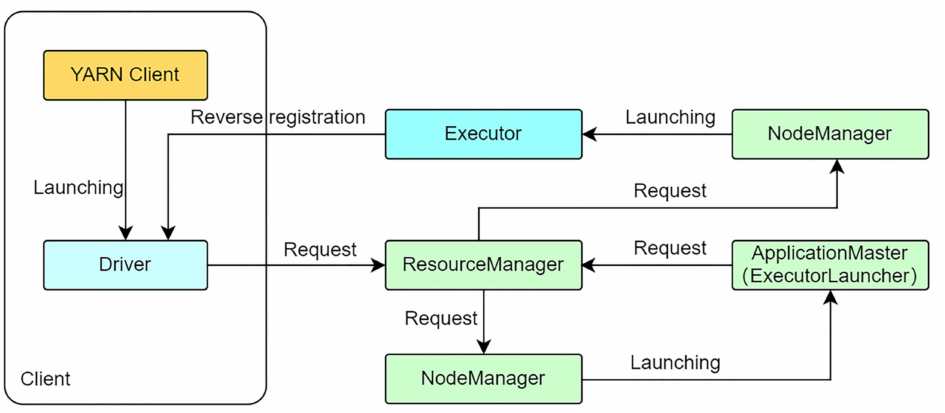
Figure 4. Principle of Spark on YARN